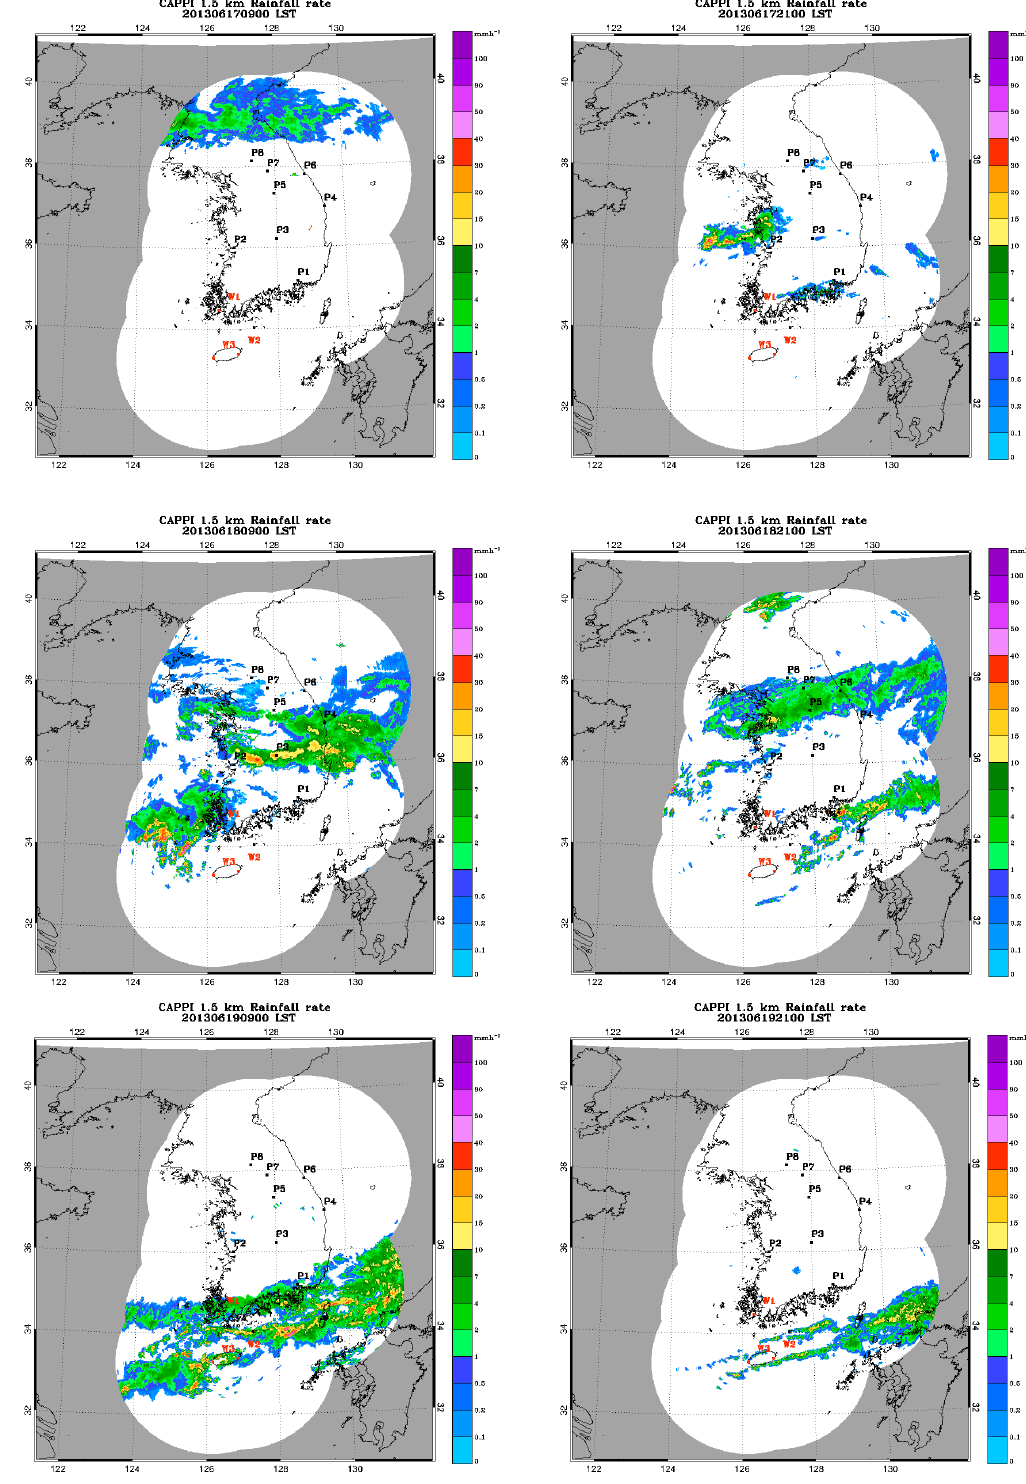
Figure 5. Composed radar images during Jangma front migration.